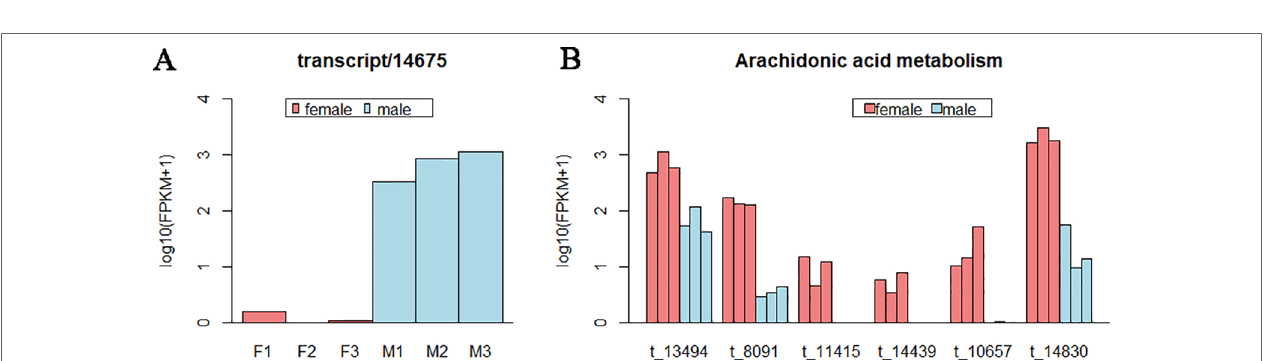
FIGURE 5 | The expression level of some differentially expressed transcripts (DETs) in gonad. (A) Expression level of the DET (transcript/14,675) shared by pathways of Fc gamma R-mediated phagocytosis, Ras signaling pathway, cyclic adenosine 3,5-monophosphate signaling pathway, and choline metabolism in cancer. (B) Expression level of DETs in the pathway of arachidonic acid metabolism. Each bar represents one sample. Different colors indicate different sexes. The abscissa represents the transcript ID. The ordinate represents the logarithm of the